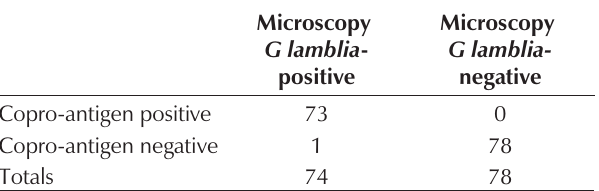
Comparison of microscopy with visual reading of Giardia lamblia copro-antigen